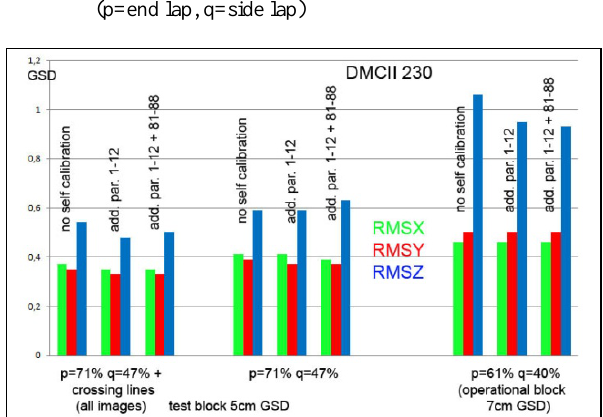
Fig. 7 : Root mean square differences at check points, adjustments with DMCII 140 9cm GSD images (p=end lap, q=side lap)